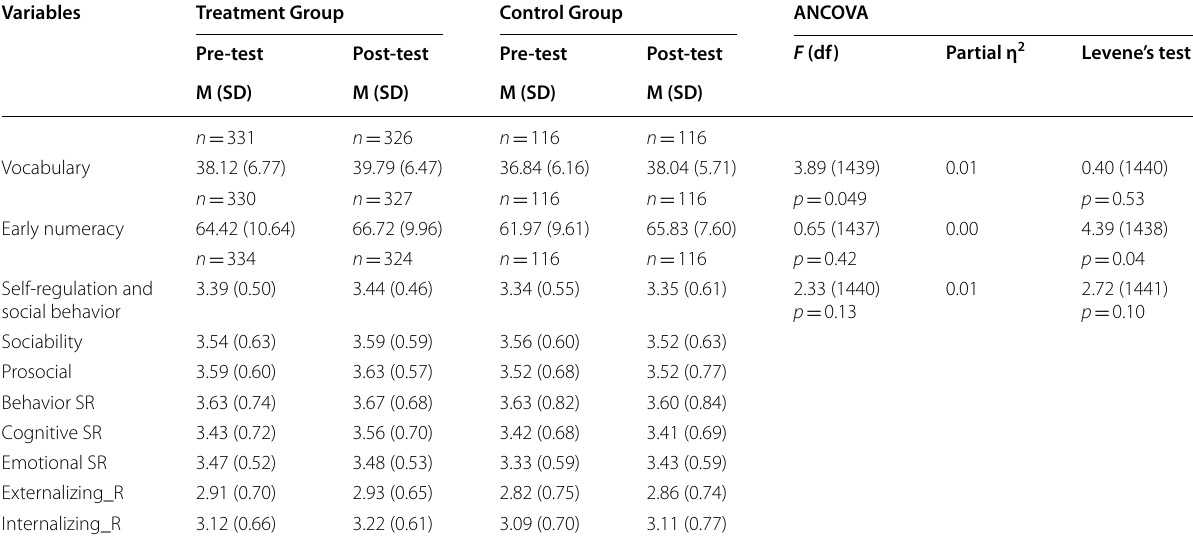
SR self-regulation, R reversed scores, ANCOVA analysis of covariance